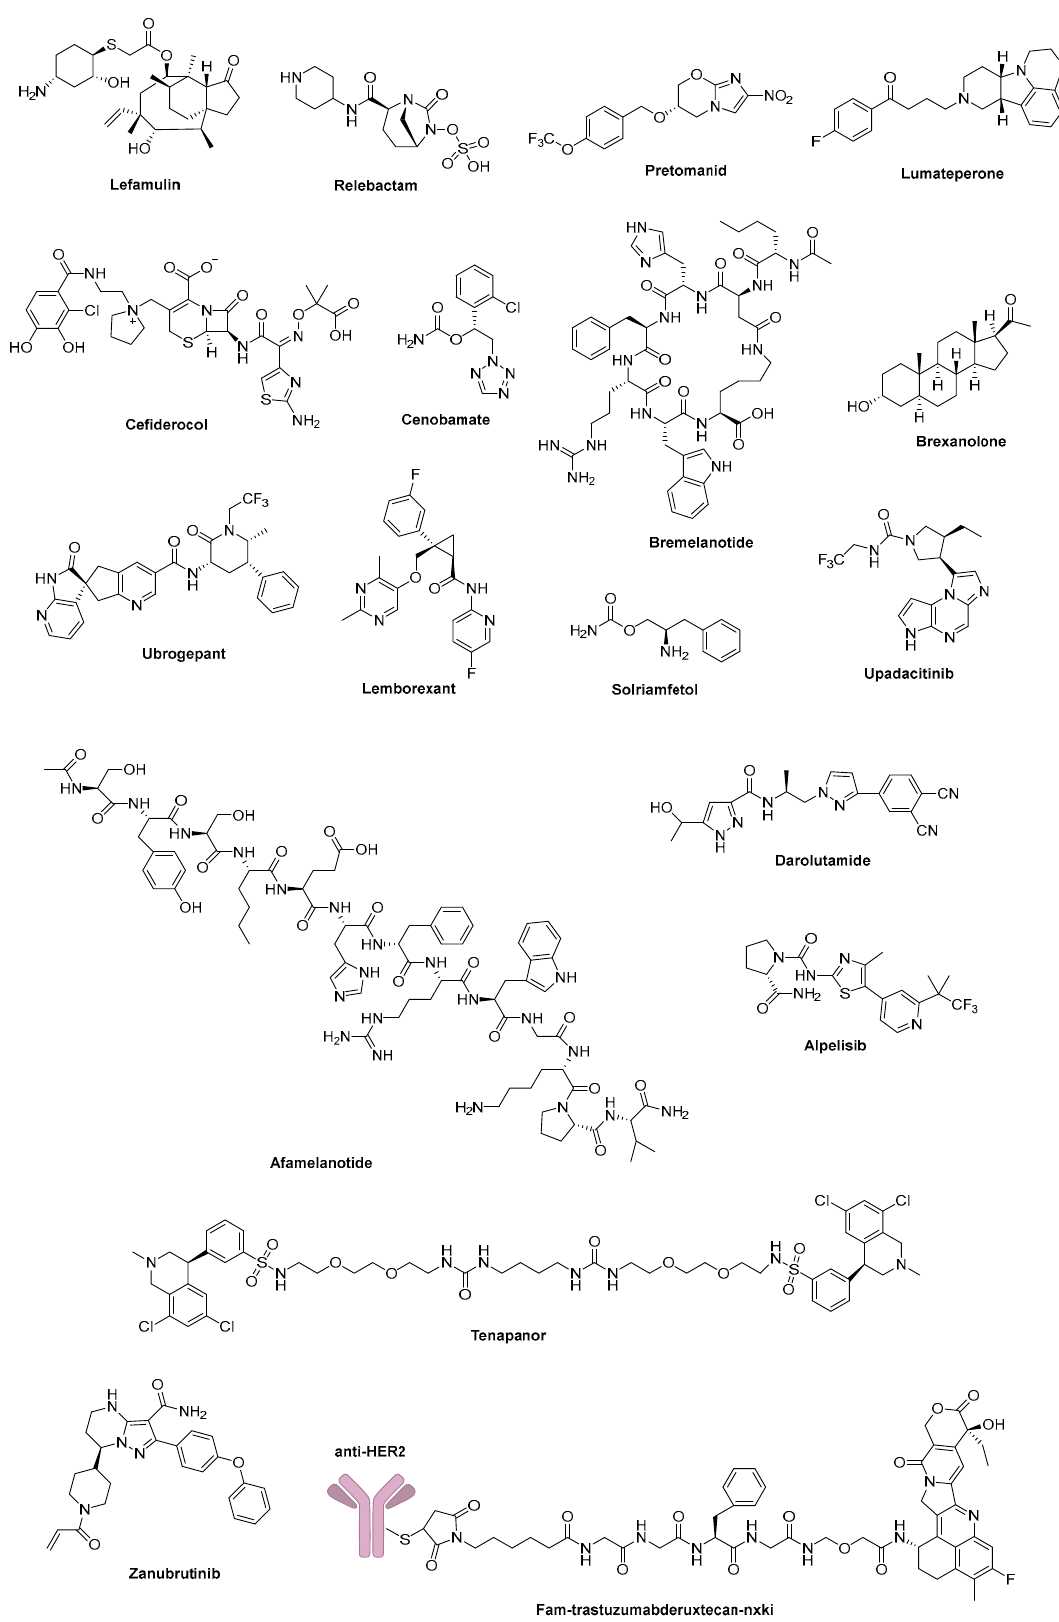
Figure 5. Structure of chiral drugs approved in 2019.